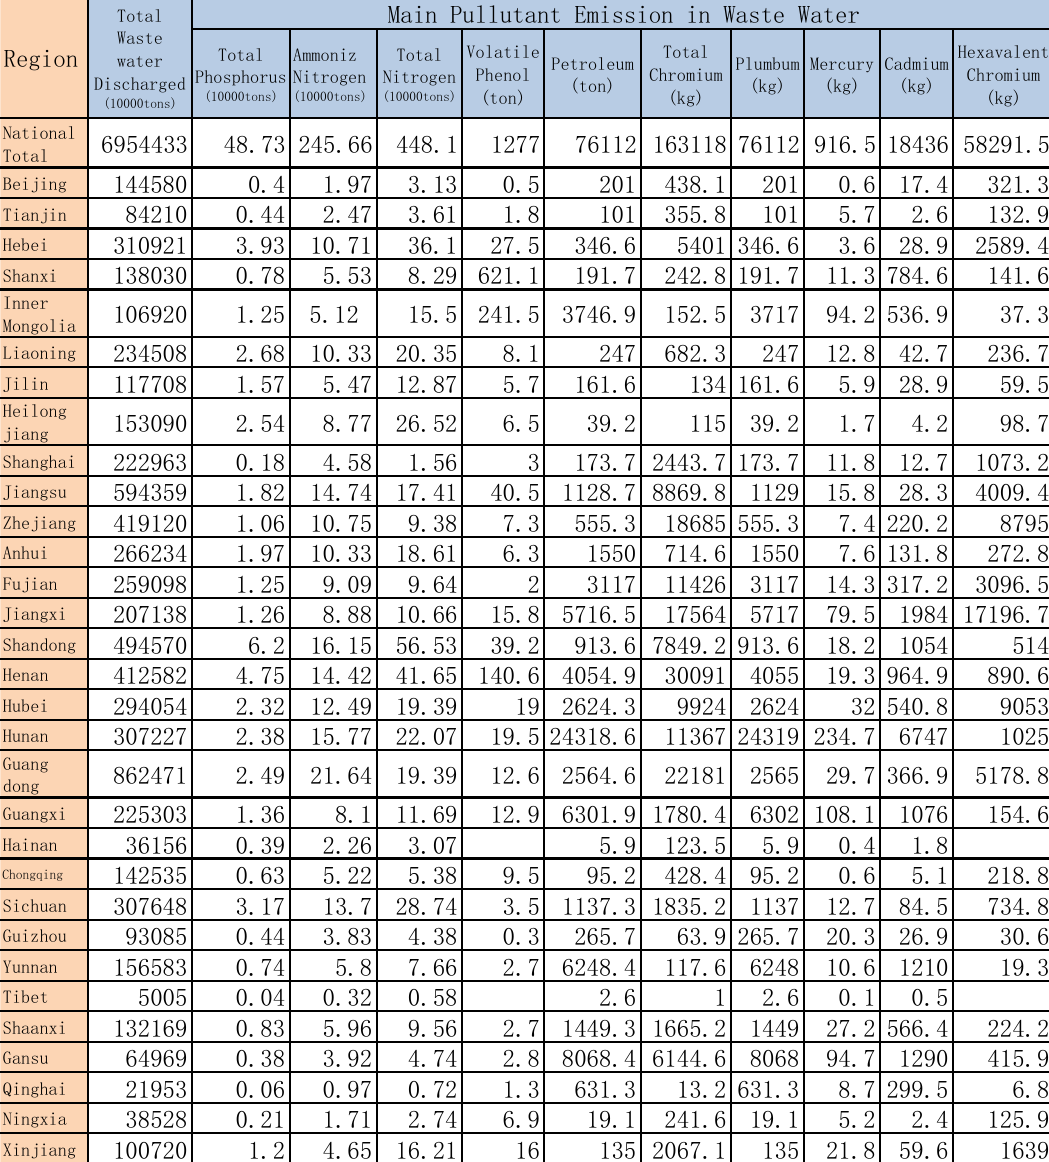
Figure A3. The main pollutant emissions in waste water by region in China in